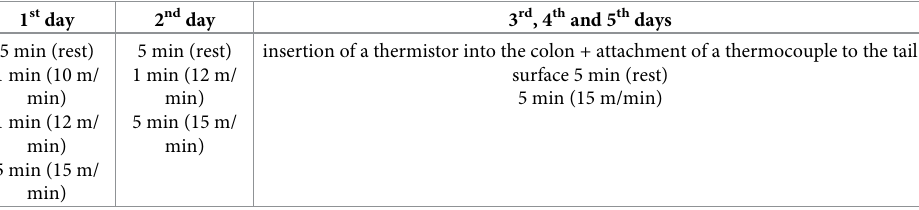
Table 1. Five-day familiarisation protocol with running on a